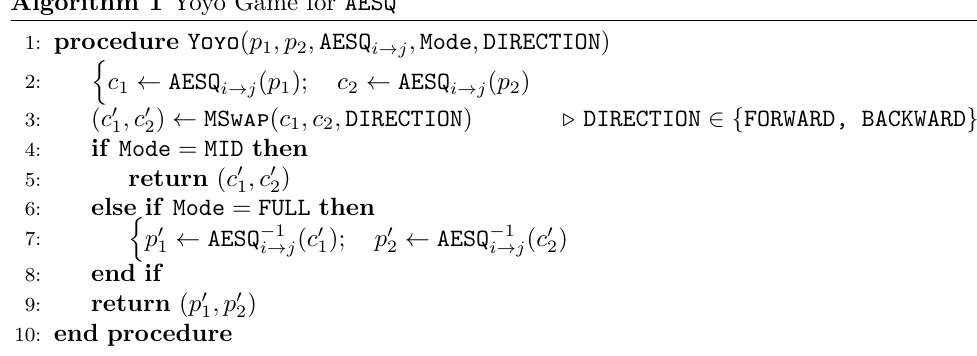
Algorithm 1 Yoyo Game for